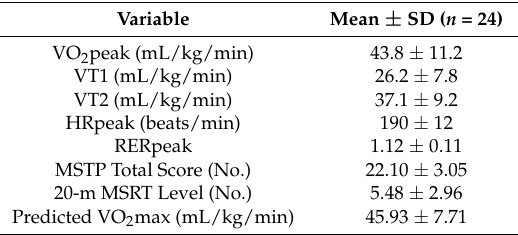
Table 2. Cardiorespiratory fitness characteristics of study participants during incremental exercise testing and field